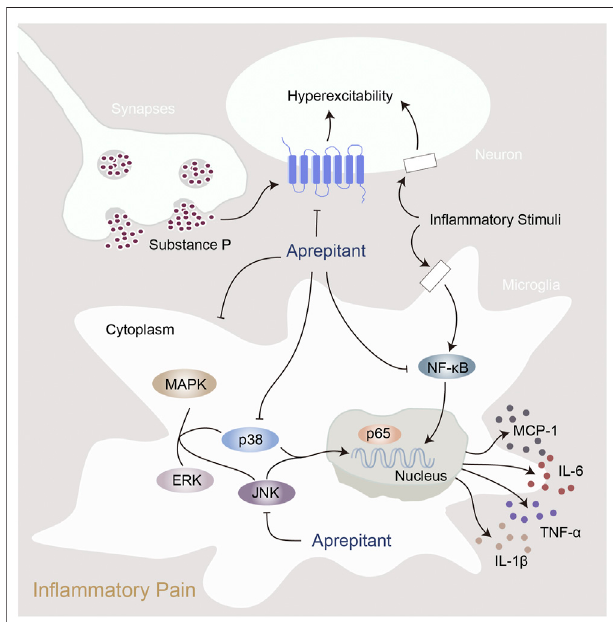
FIGURE 7 | Proposed mechanisms of action by which aprepitant inhibited in fl ammation in mice with in fl ammatory pain.